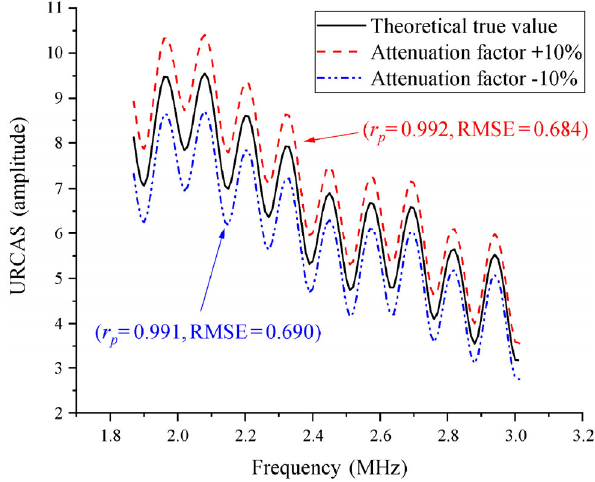
Fig. 7 Effect of attenuation factor fluctuation ± 10% on